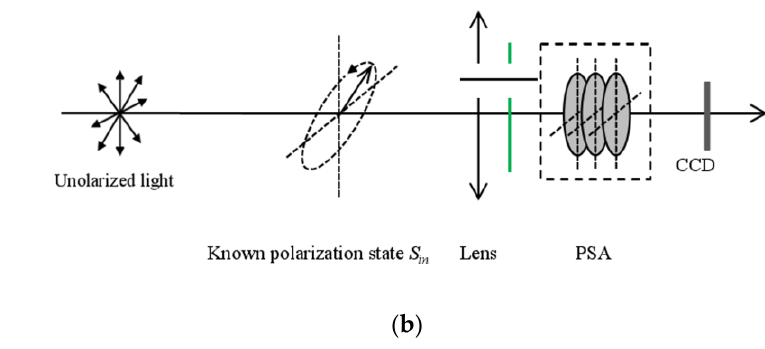
Figure 4. Major polarization imaging devices ( a ) SALSA camera; ( b ) Structure diagram.